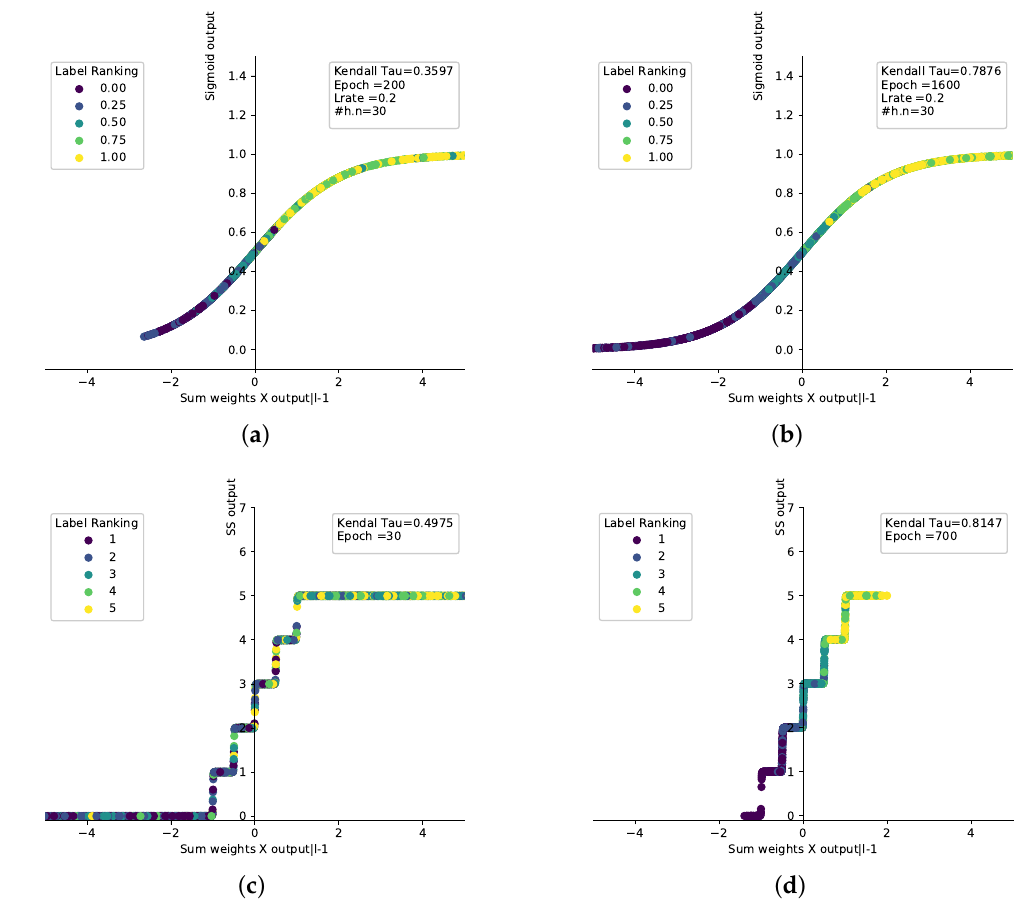
Figure 3. The graphical comparison between convergence of Sigmoid and SS functions to rank stock dataset, ( a ) Sigmoid has τ = 0.3597 and epoch = 200. ( b ) Sigmoid has τ = 0.7876 and epoch = 1600. ( c ) SS has τ = 0.4975 and epoch = 30. ( d ) SS has τ = 0.8147 and epoch =